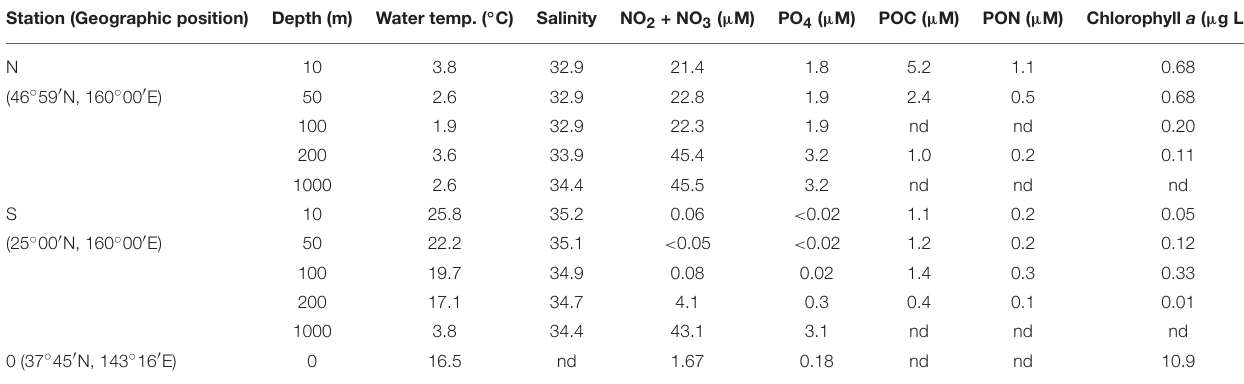
TABLE 1 | Physical and chemical properties of seawater